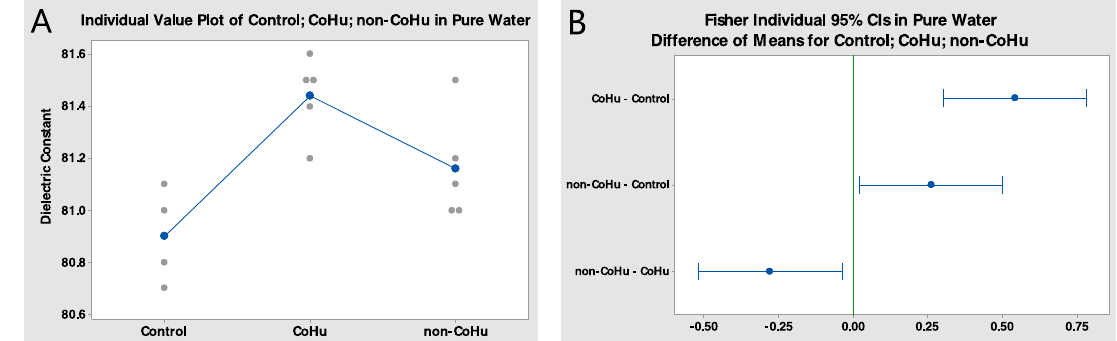
Figure 4. ( A ) Pure water dielectric constant scattered data in samples treated with CoHu and non-CoHu. ( B ) Fisher pairwise comparisons for dielectric constant measurements in pure water. CIs are confidence intervals. If an interval does not contain zero, the corresponding means are significantly different.